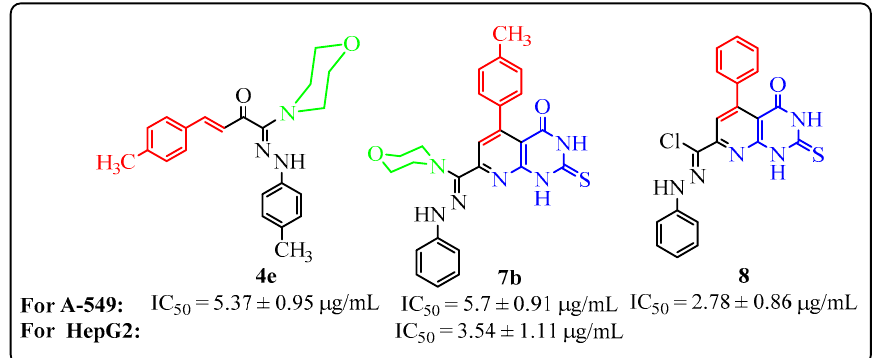
Figure 1. The most active compounds compared to cisplatin.